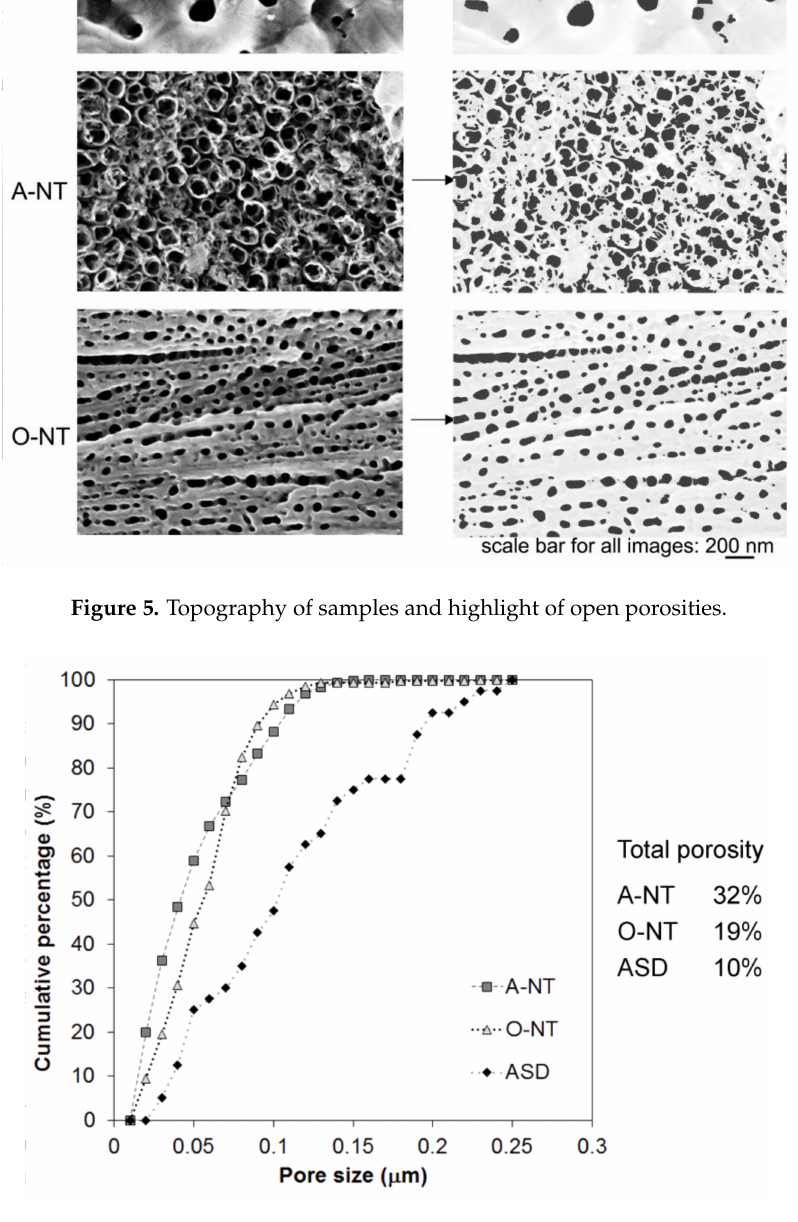
Figure 6. Analysis of porosities appearing on the three oxides